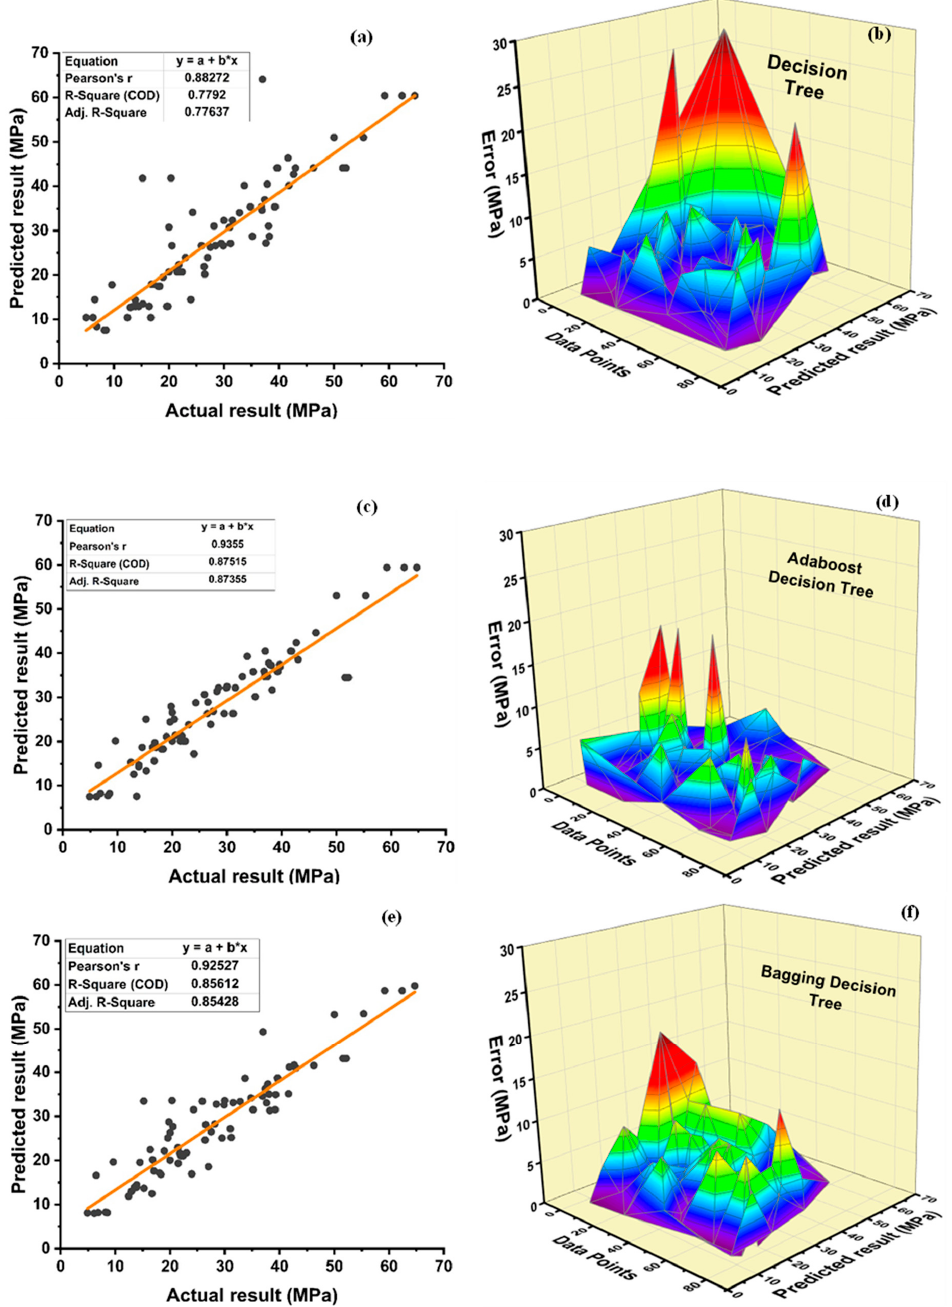
Figure 12. Compressive strength: ( a ) DT regression model; ( b ) DT model error distribution; ( c ) DT- adaboost model; ( d ) DT-adaboost model error distribution; ( e ) DT-bagging regression model; and ( f ) DT-bagging model error distribution.